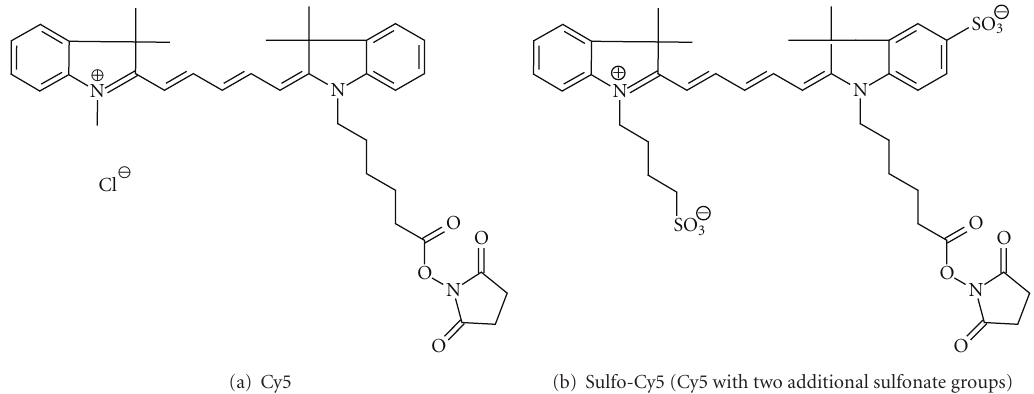
(b) Sulfo-Cy5 (Cy5 with two additional sulfonate groups) Figure 1: Chromophore structures of